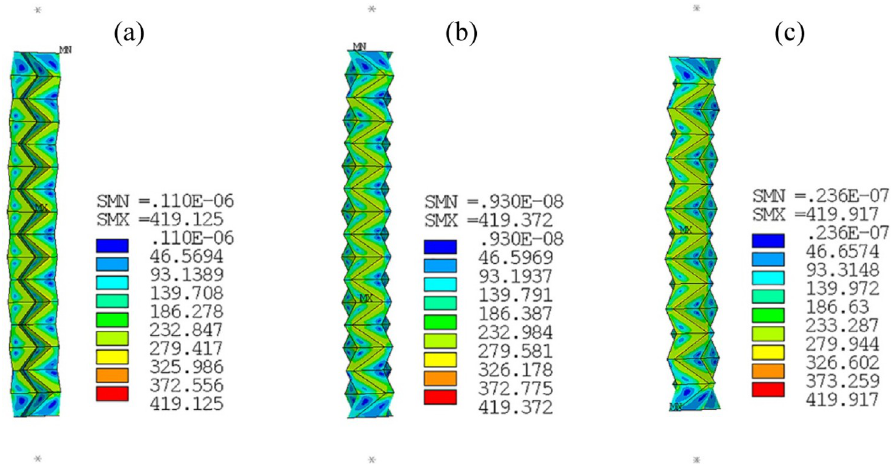
Fig 14. Deformation and stress distribution of tubes at peak points. (a) C-ORI-L-1; (b) C-ORI-L-2; (c) C-ORI-L-4.